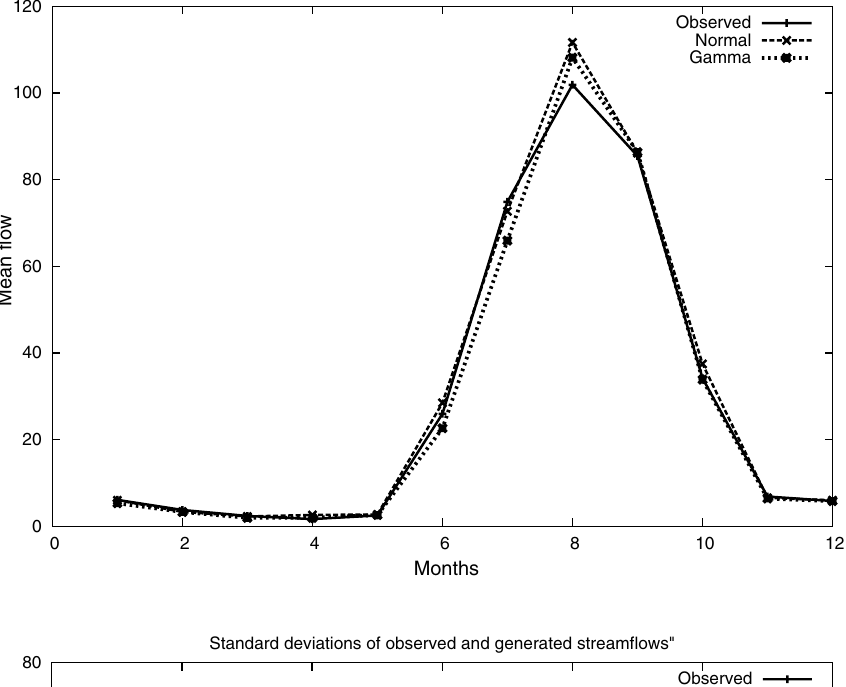
Fig. 16 Historical and generated monthly standard deviations of flows in Barakar River (multi- site